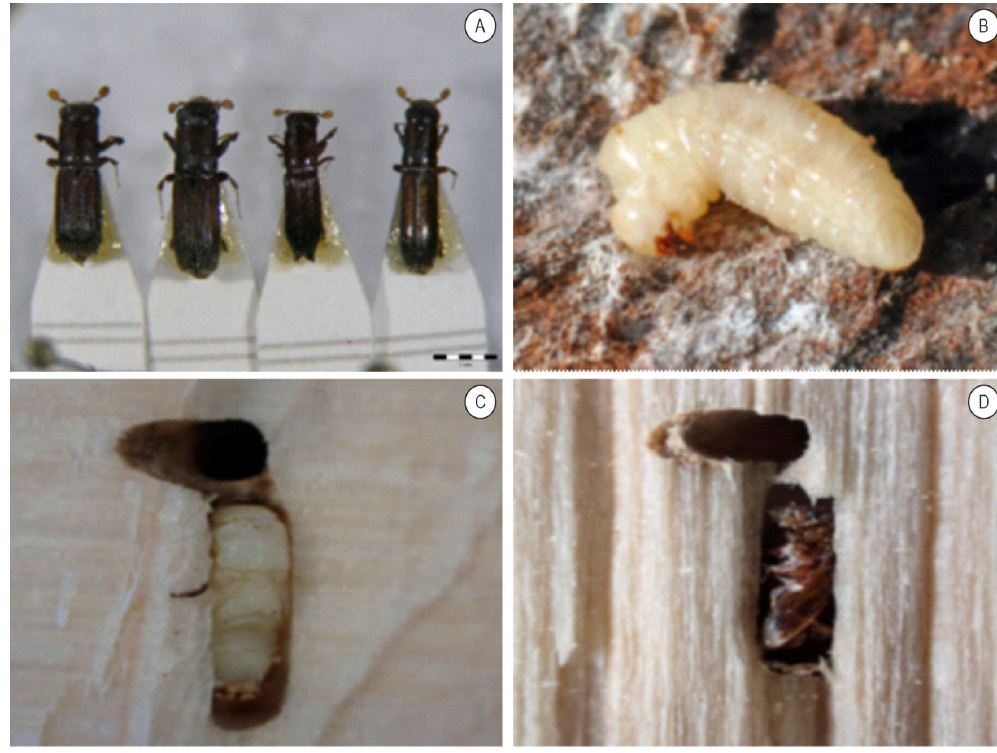
Figure 7. ( A ) Adults of P. cylindrus and T. oxyurus (from left to right P. cylindrus ♂ , P. cylindrus ♀ , T. oxyurus ♂ , T. oxyurus ♀ ); ( B ) larva of T. oxyurus ; ( C ) pupa libera of T. oxyurus ; ( D ) young adult of T. oxyurus inside gallery system.